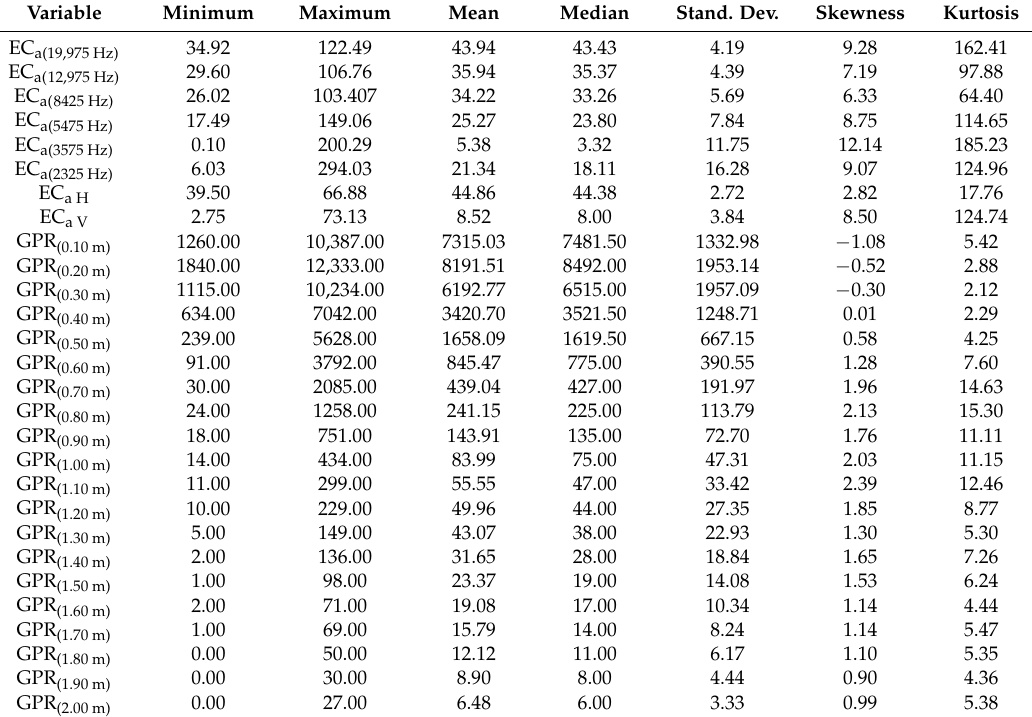
Table 1. Basic statistics of the selected geophysical variables used in the study. EC a(- Hz) are the apparent electrical conductivities (mS · m − 1 ) measured by the GEM Profiler at the different operating frequencies; EC a H and EC a V are the apparent electrical conductivities (mS · m − 1 ) measured by the EM38DD in horizontal (H) and vertical (V) polarization; GPR (- m) are the GPR signal amplitude (-) at the different depth